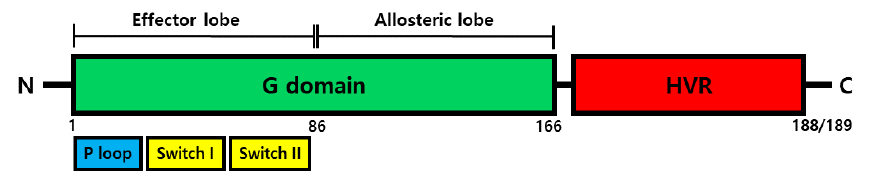
Figure 3. Structure analysis of KRAS. Schematic representation of the full-length KRAS isoform domain. KRAS consists of G domain (residue 1–166) and hypervariable region (HVR, residue 167–188/189). G domain is divided into effector lobe (residue 1–86) and allosteric lobe (residue 87–166). In addition, effector lobe consists of P-loop-phosphate binding loops (residue 10–16), Switch I (residue 30 – 38), and Switch II (residue 59 – 76).